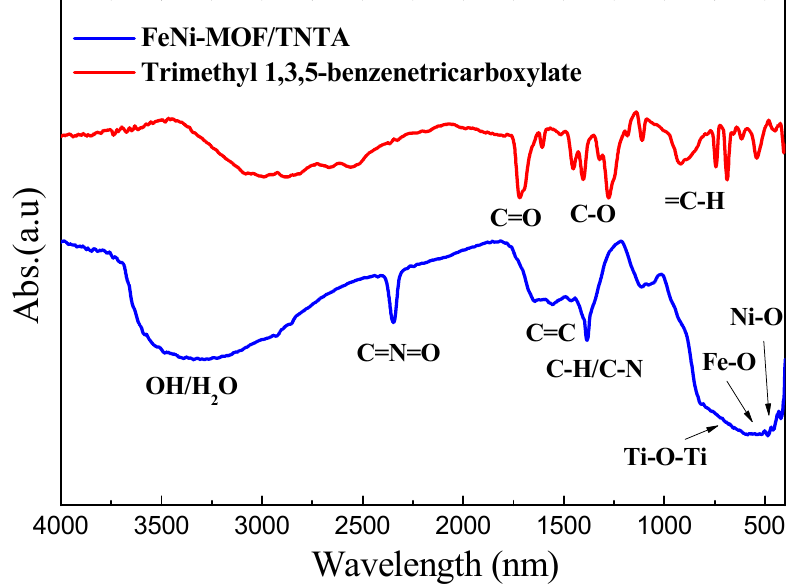
Figure 4. Fourier transform infrared (FTIR) spectra of FeNi-MOF / TNTA (0.03M_Fe / 0.01M_Ni), TNTA, and trimethyl 1,3,5-benzenetricarboxylate.